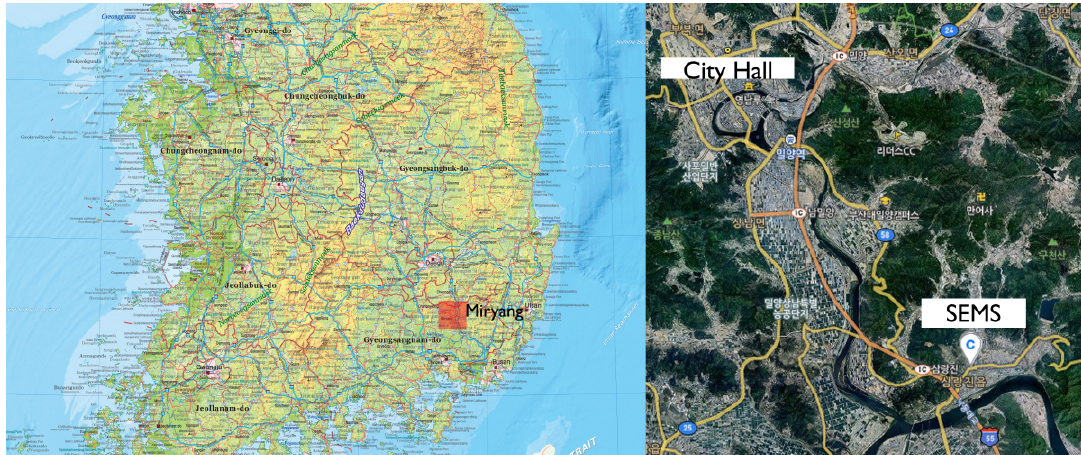
Figure 1. The location of SESM in South Korea.